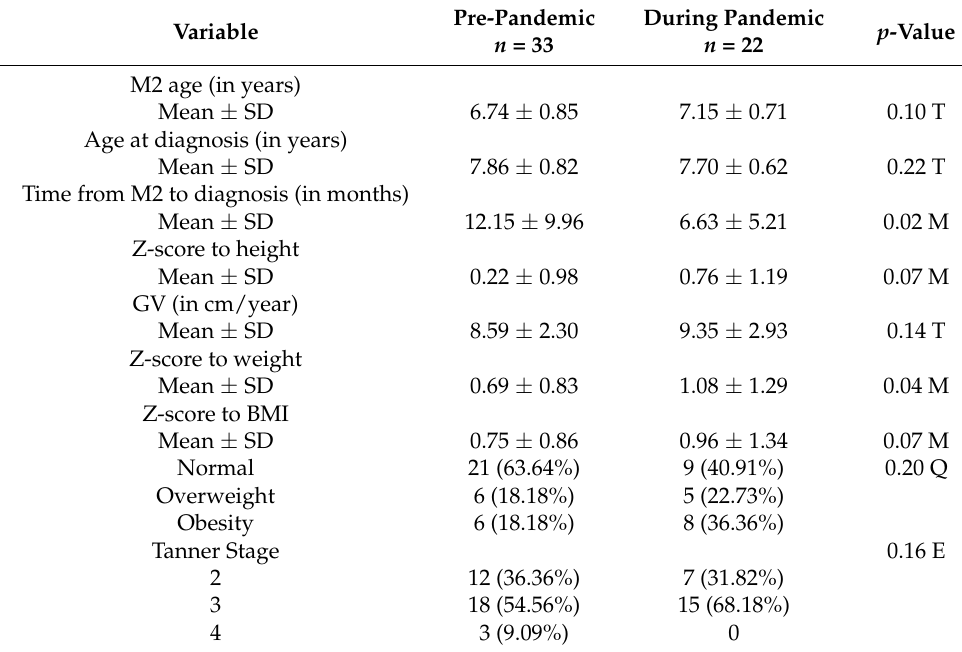
Table 1. Clinical and anthropometric characteristics of girls with precocious puberty before and during the COVID-19 pandemic ( n = 55).